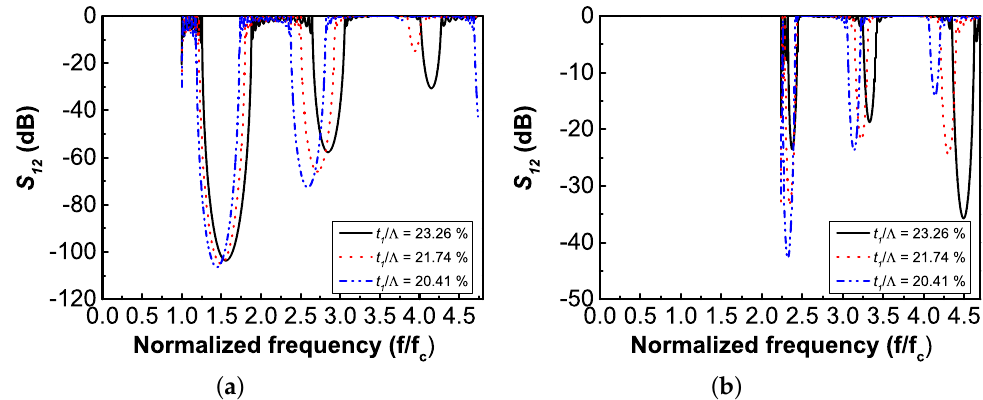
Figure 2. Calculated transmittance, S 12 (dB), of the quasi-1D PCs with 15 double-layer stacks enclosed in the rectangular waveguide for ( a ) TE 10 and ( b ) TM 11 modes of light propagation. The dielectric constants used are ε 1 = 3.8 and ε 2 = 1.0, and the corresponding filling ratios are t 1 / Λ = 23.26%, 21.74%, and 20.41% in the three cases. The frequency axes are normalized to the cutoff frequency of TE 10